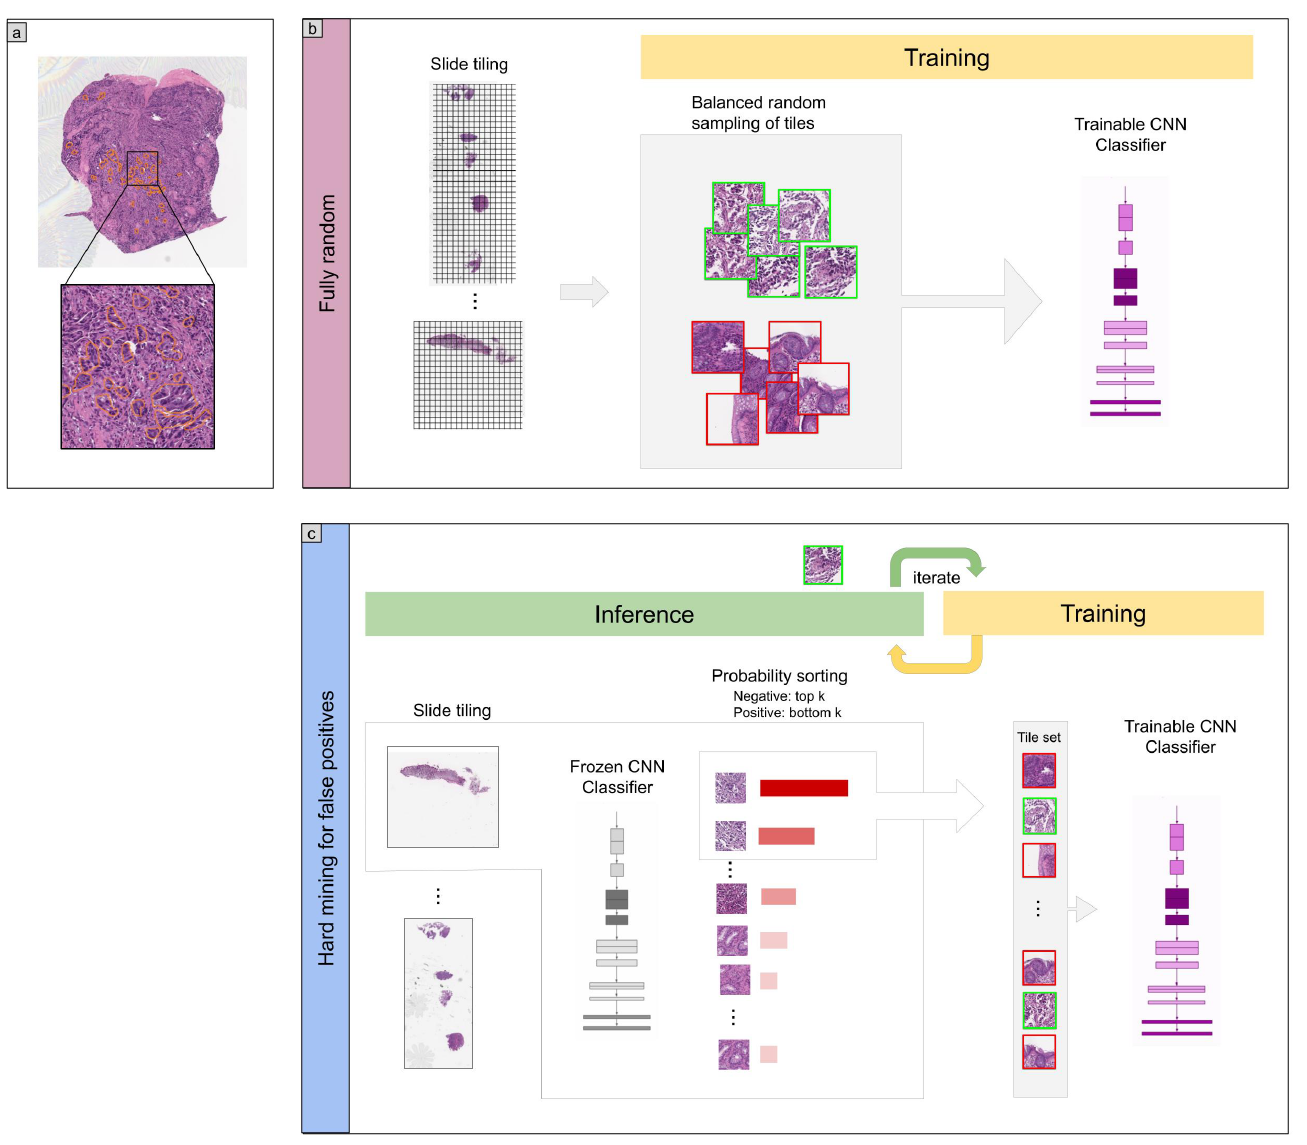
Figure 1. Method overview. ( a ) An example of poorly differentiated ADC annotation that was carried out on the WSIs by pathologists using in an in-house web-based application. ( b ) The initial training consisted in fully-random balanced sampling of positive (poorly differentiated ADC) and negative tiles to fine-tune the models. ( c ) After a few epochs of random sampling, the training switched into iterative hard mining of tiles that alternates between training and inference. During the inference step, we applied the model in a sliding window fashion on all of the WSI and selected the k tiles with the highest probabilities if the WSI was negative, and k tiles with the lowest probabilities if the WSI was positive. The tiles were collected in a subset that was batched and used for training. This process allows training to reduce false